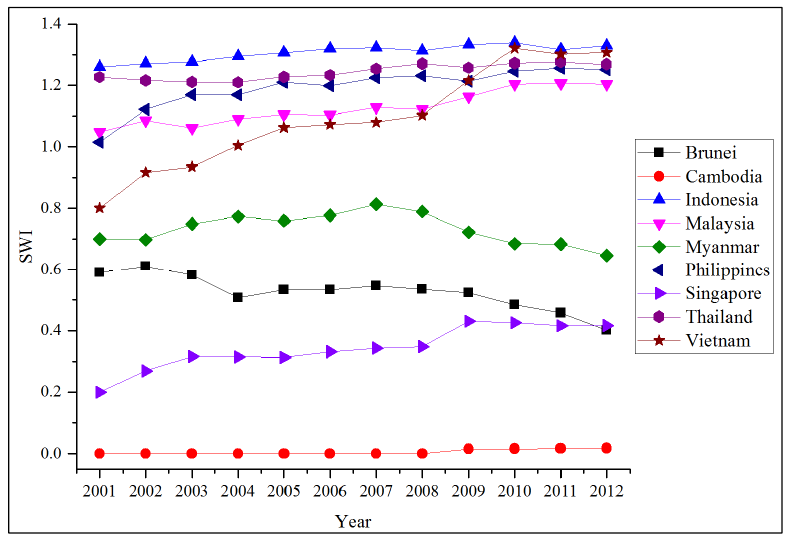
Figure 45. Diversity of primary energy